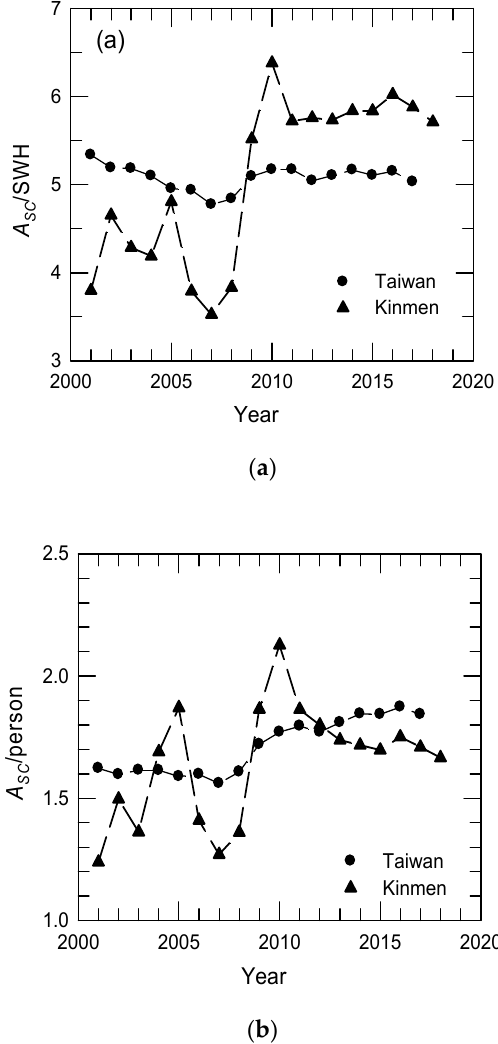
Figure 8. Scale of SWHs (2001–2018) in Taiwan and Kinmen County. ( a ) Area of solar collectors per SWH; ( b ) Area of solar collectors per